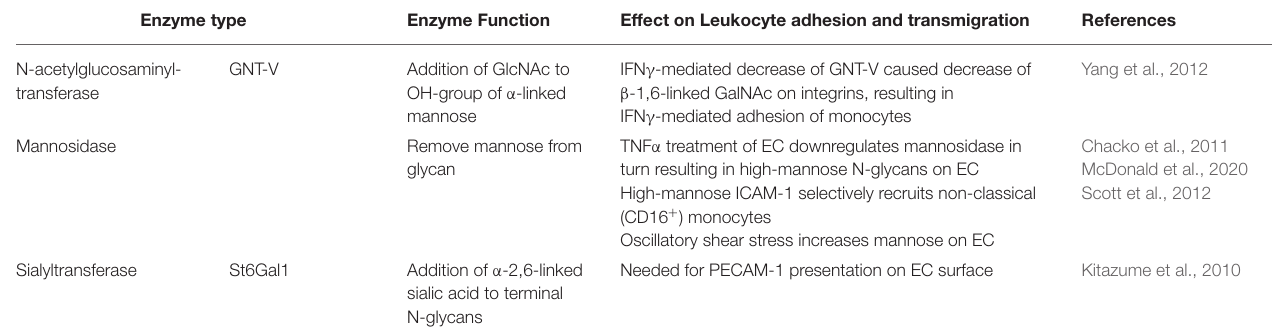
TABLE 2 | Enzymes involved in Leukocyte Adhesion and Transmigration. Enzyme type Enzyme Function Effect on Leukocyte adhesion and